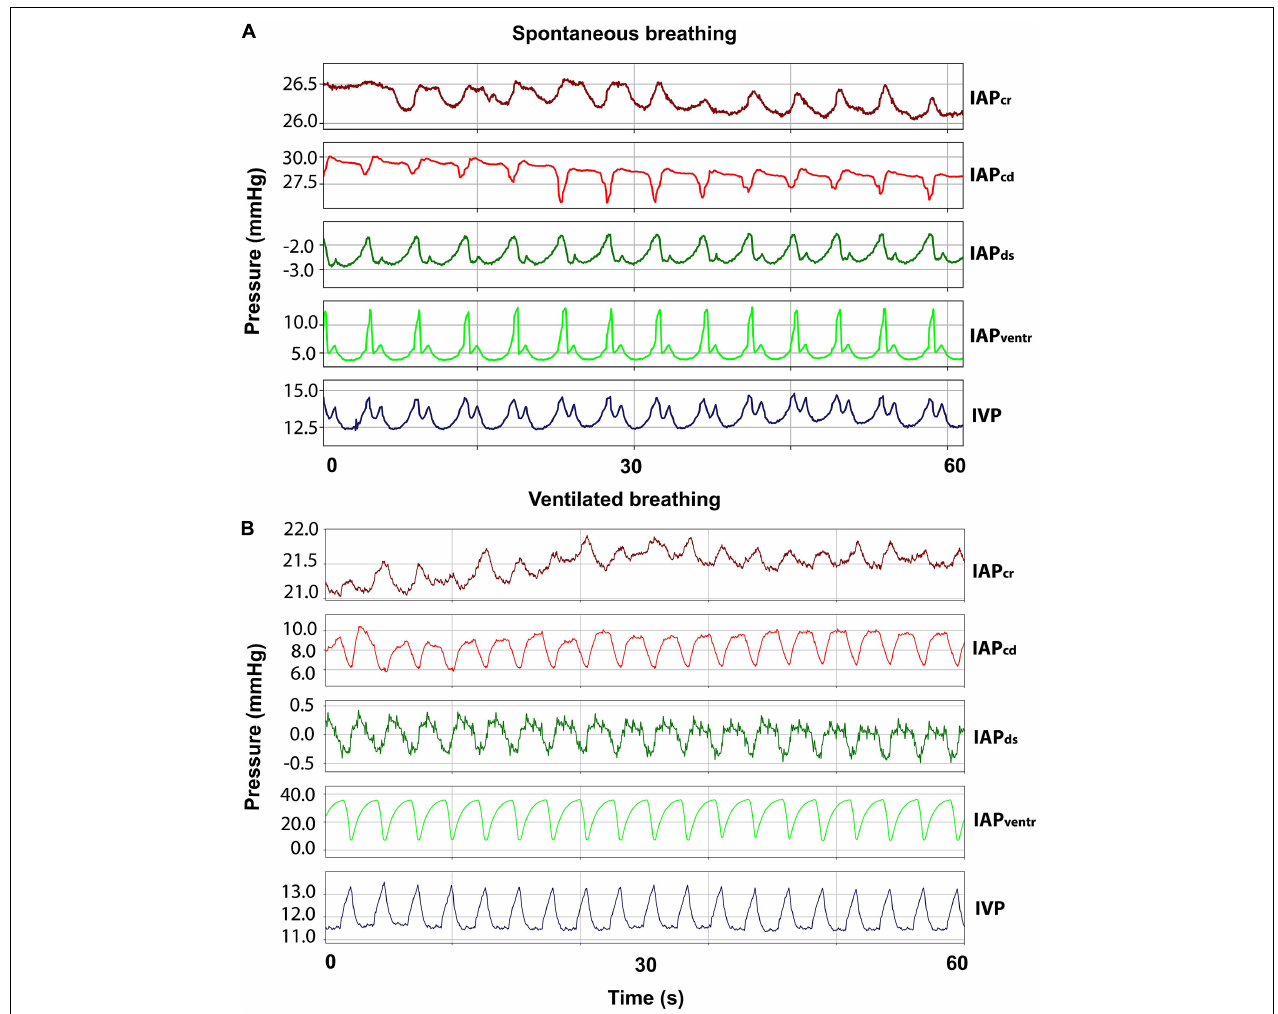
FIGURE 3 | Respiratory abdominal waveforms. (A) Curves for cranial (IAP cr ), caudal (IAP cd ), dorsal (IAP ds ), and ventral (IAP ventr ) intraabdominal pressure as well as intravesical pressure (IVP) during spontaneous breathing. (B) IAP and IVP curves during ventilated